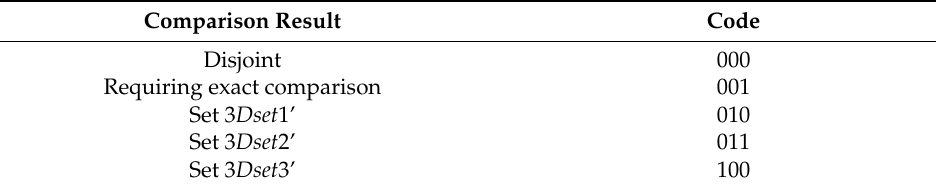
Table 10. The comparison result lookup table.